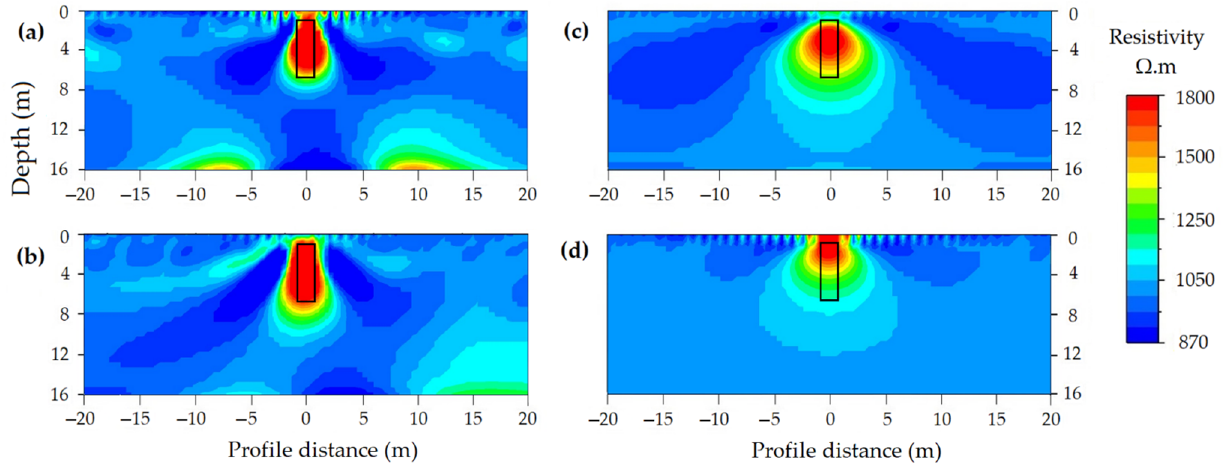
Figure 16. The inverted resistivity model for the inclined (45°) cavity using: ( a ) DD array, ( b ) PD array, ( c ) WS array, ( d ) PP array. The box indicates the actual cavity target.